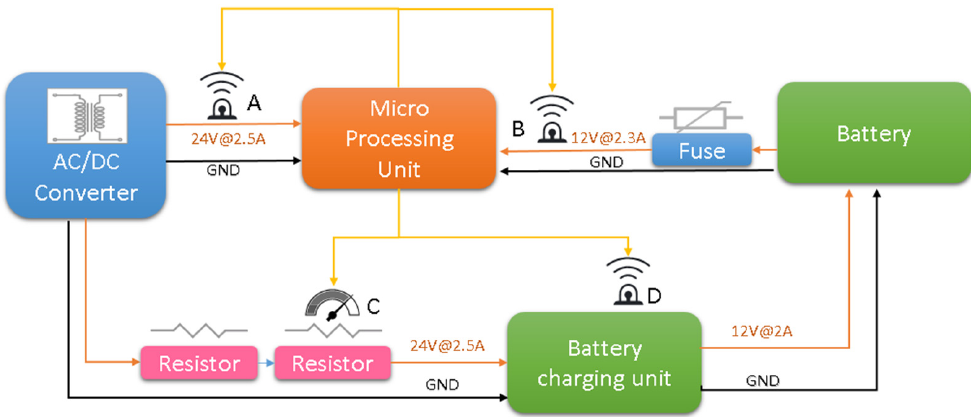
Figure 3. Block diagram of the DC input